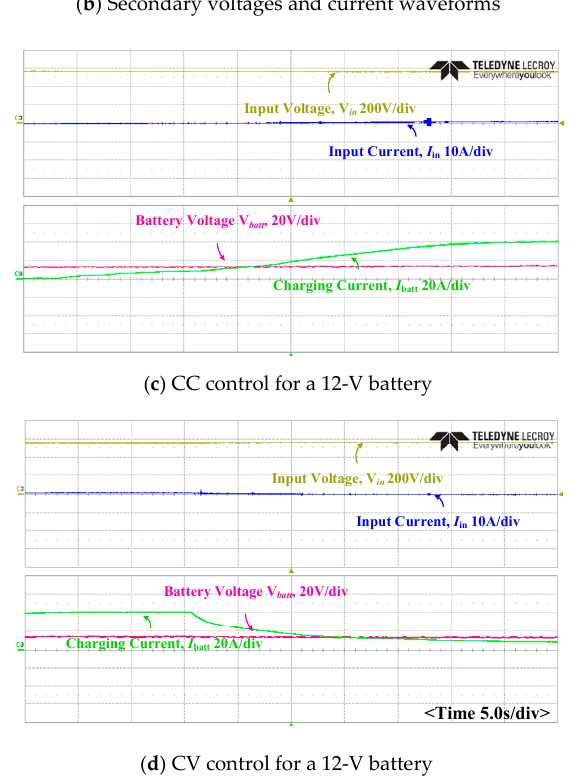
Figure 20. Experimental results of Switching Pattern 4.